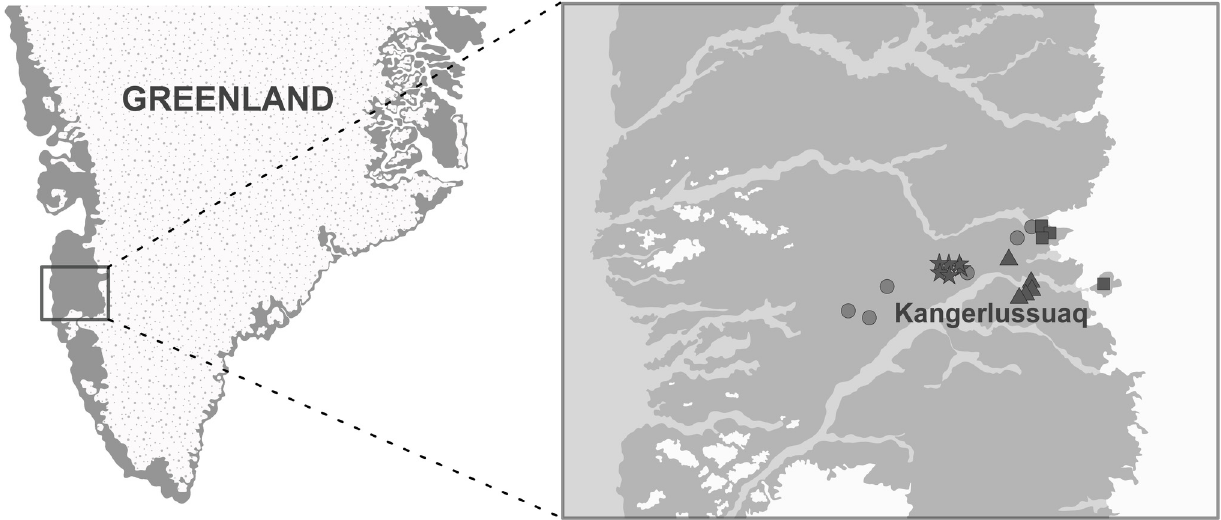
Fig 1. Distribution of the 15 study lakes in southwest Greenland along a 50-km southwesterly transect from the ice sheet. Lakes were classified into clusters for analysis (see Table 1) as indicated by the following symbols: Cluster A = squares, Cluster B = triangles, Cluster C = stars, lakes sampled in 2013 =